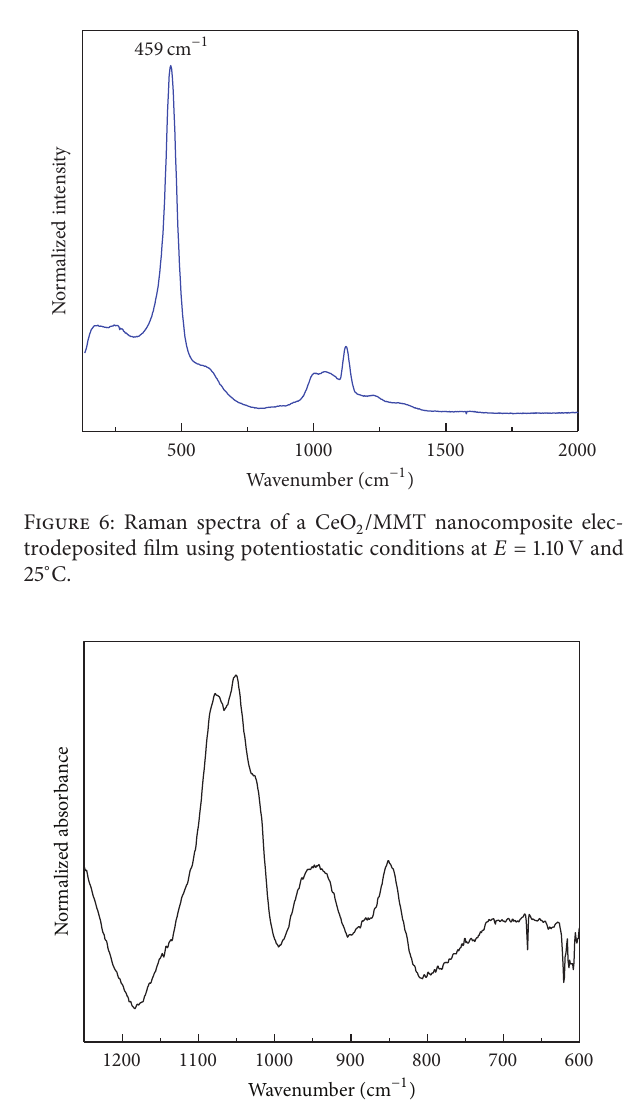
(sticking) with the nanoprobe tip. Additional mechanical experiments are needed to help elucidate the mechanical properties of the films.